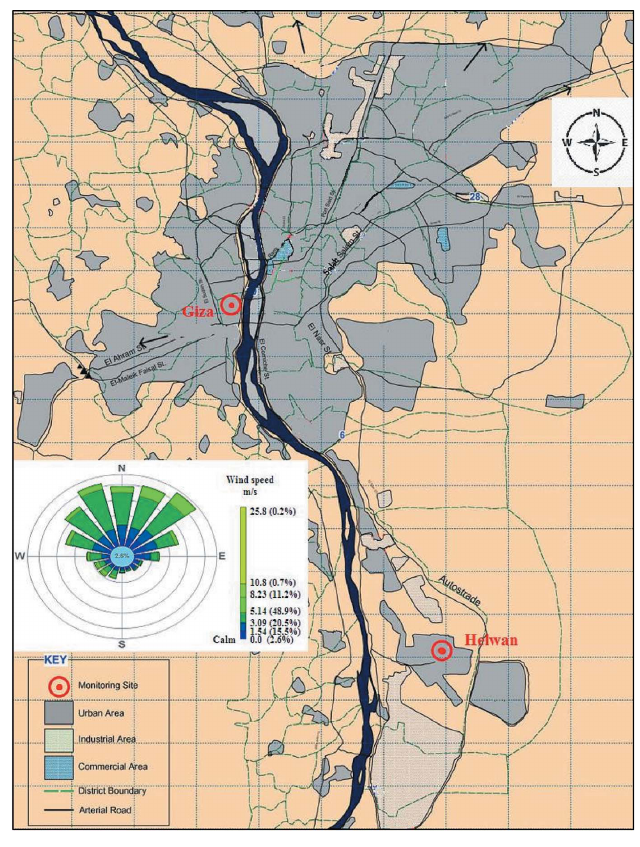
Figure 1 The wind rose of the GC area and the locations of the Giza and Helwan sampling stations (modified from Lowenthal et al. ,